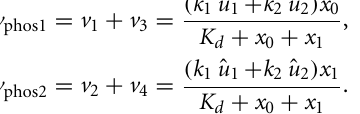
that only one enzyme can be bound to the kinase at any one